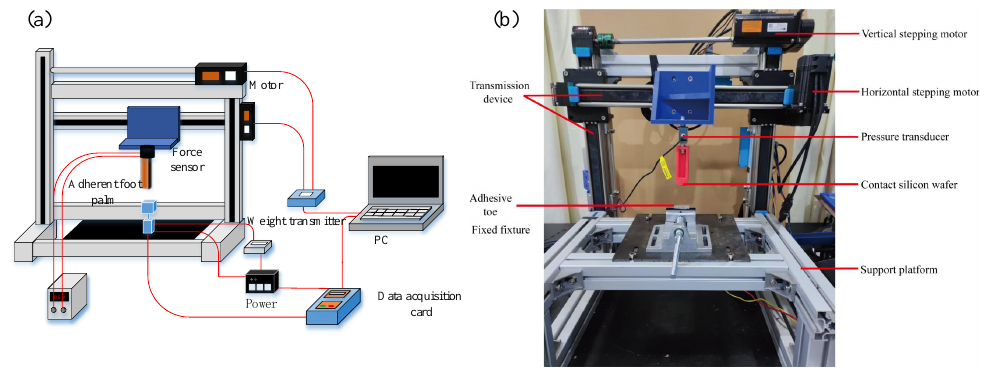
Figure 16. Test platform for the adhesion ability of the foot: ( a ) schematic diagram and ( b ) experi- mental